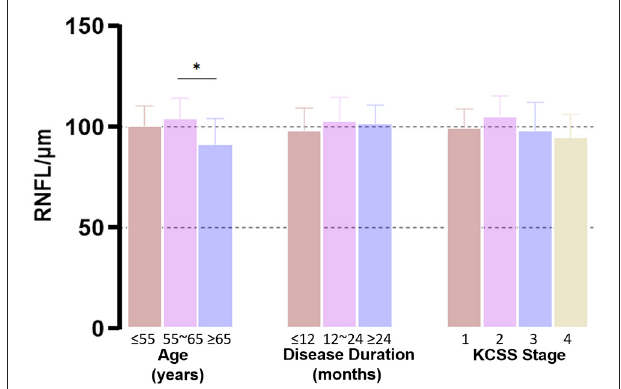
FIGURE 1 | Group-wise comparison of RNFL. ALS patients were grouped according to age, disease duration and KCSS. We detected a significantly thinner RNFL in older ( ≥ 65 years) subjects ( p = 0.020). There were no significant differences between groups when stratified by disease duration (